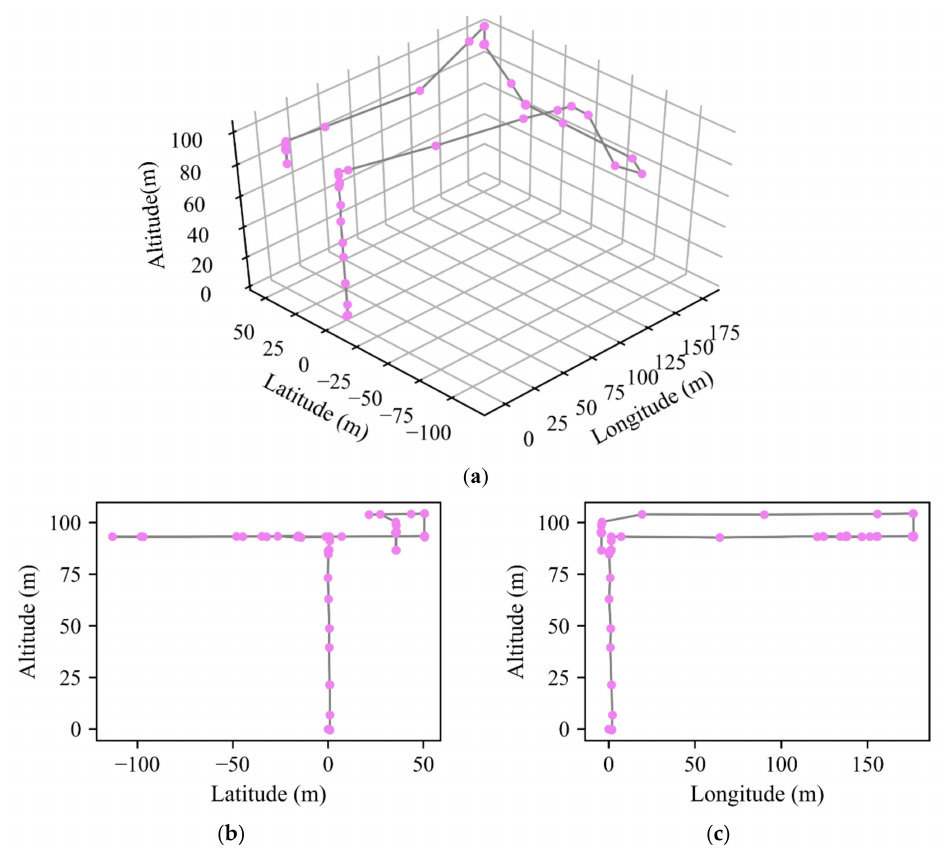
Figure 1. ( a ) The three-dimensional view; ( b , c ) the side views of a quadrotor